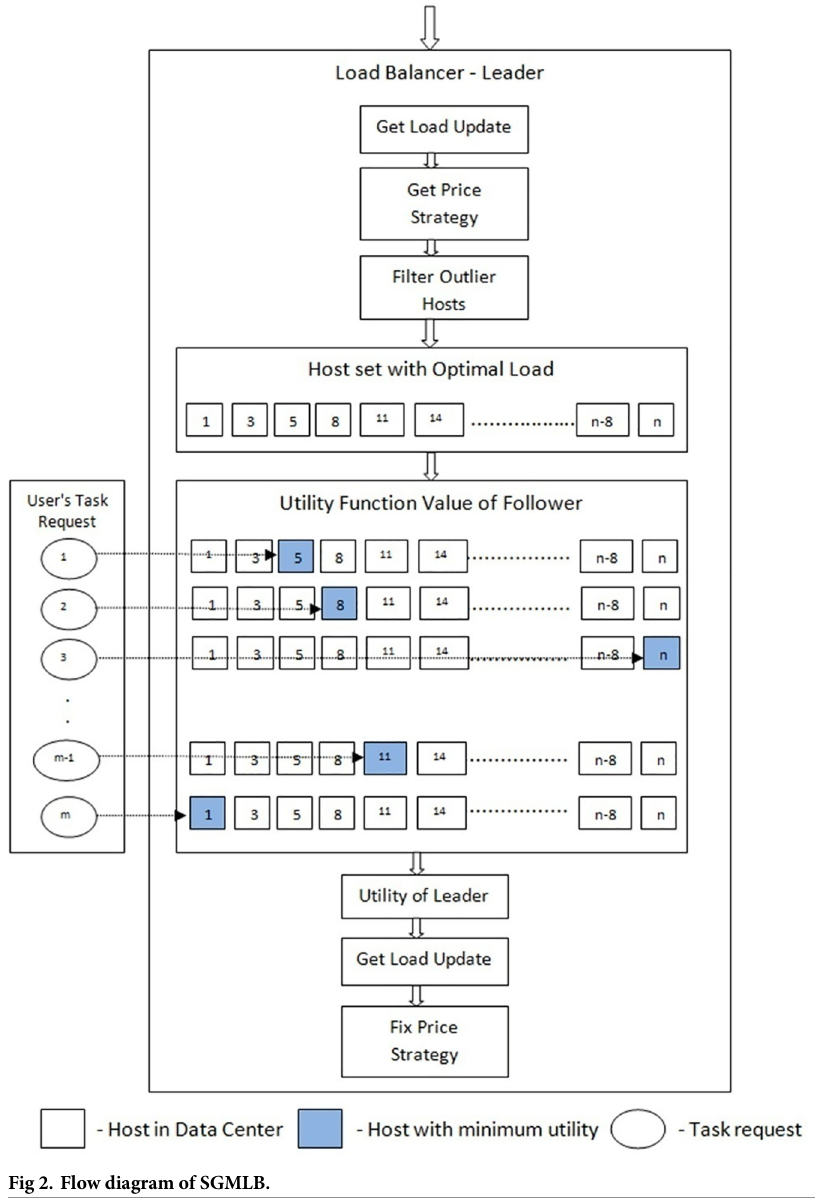
Fig 2. Flow diagram of